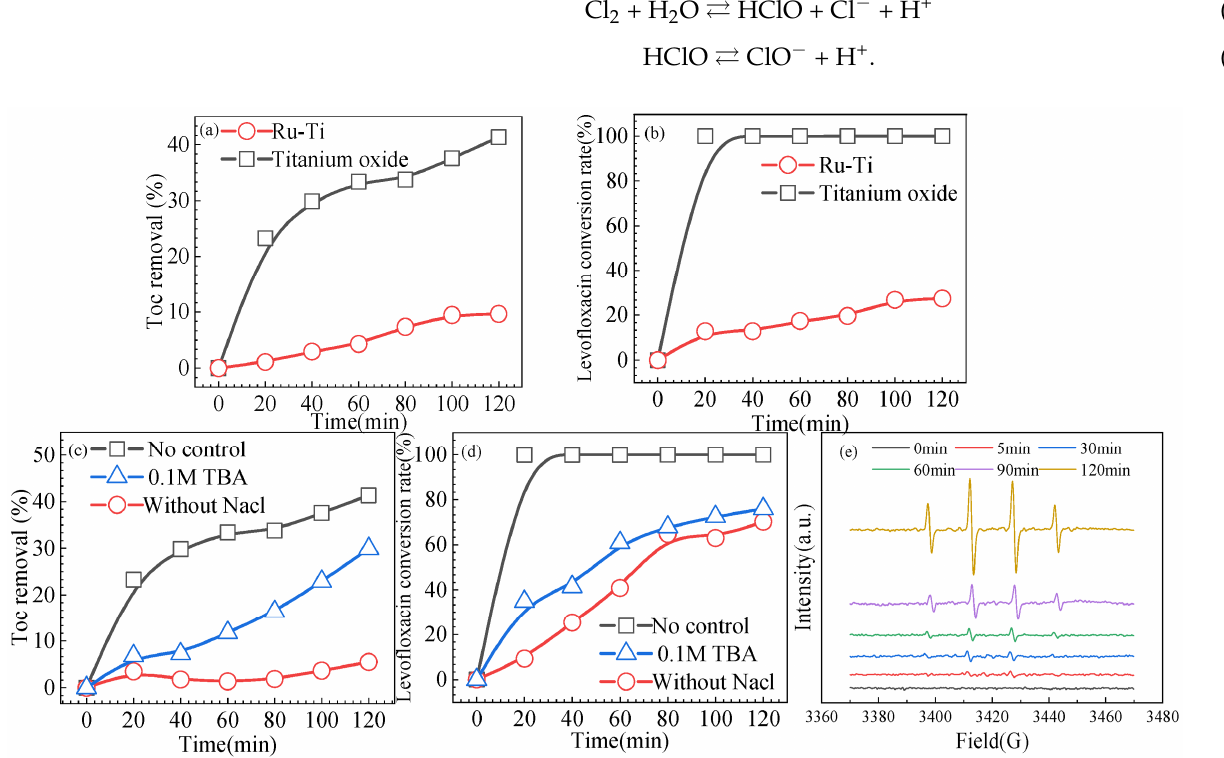
Figure 7. ( a ) TOC removal and ( b ) LVX conversion rates of ruthenium–titanium electrode and titanium suboxide under optimal reaction conditions (current density of 39.6 A/m 2 , initial pH of 4, flow rate of 50 mL/min, chloride ion concentration of 4%, and reaction time of 120 min). ( c ) Effect of NaCl and TBA on TOC removal. ( d ) Effect of NaCl and TBA on LVX conversion. ( e ) EPR spectra of hydroxyl